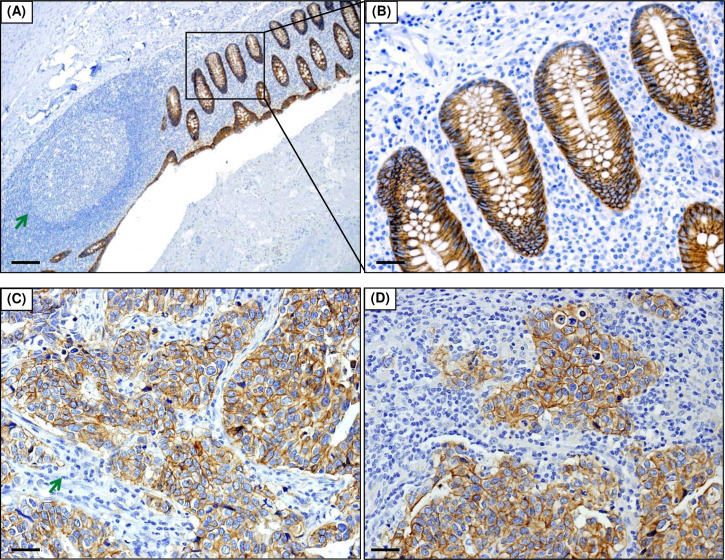
TRPM4 protein expression in representative control tissues and breast cancer cases.(A) TRPM4 expression by IHC in appendix as the control tissues (magnification: 40x). The green arrow shows the germinal centre negative for TRPM4 expression. (B) Higher magnification (200x) of the inset in (A). (C-D) Representative breast cancer tissues with high TRPM4 expression in breast cancer cells while negative in surrounding lymphocytes or stromal cells (green arrows). Scale bar for (A): 200 μm; Scale bar for (B-D): 50 μm.